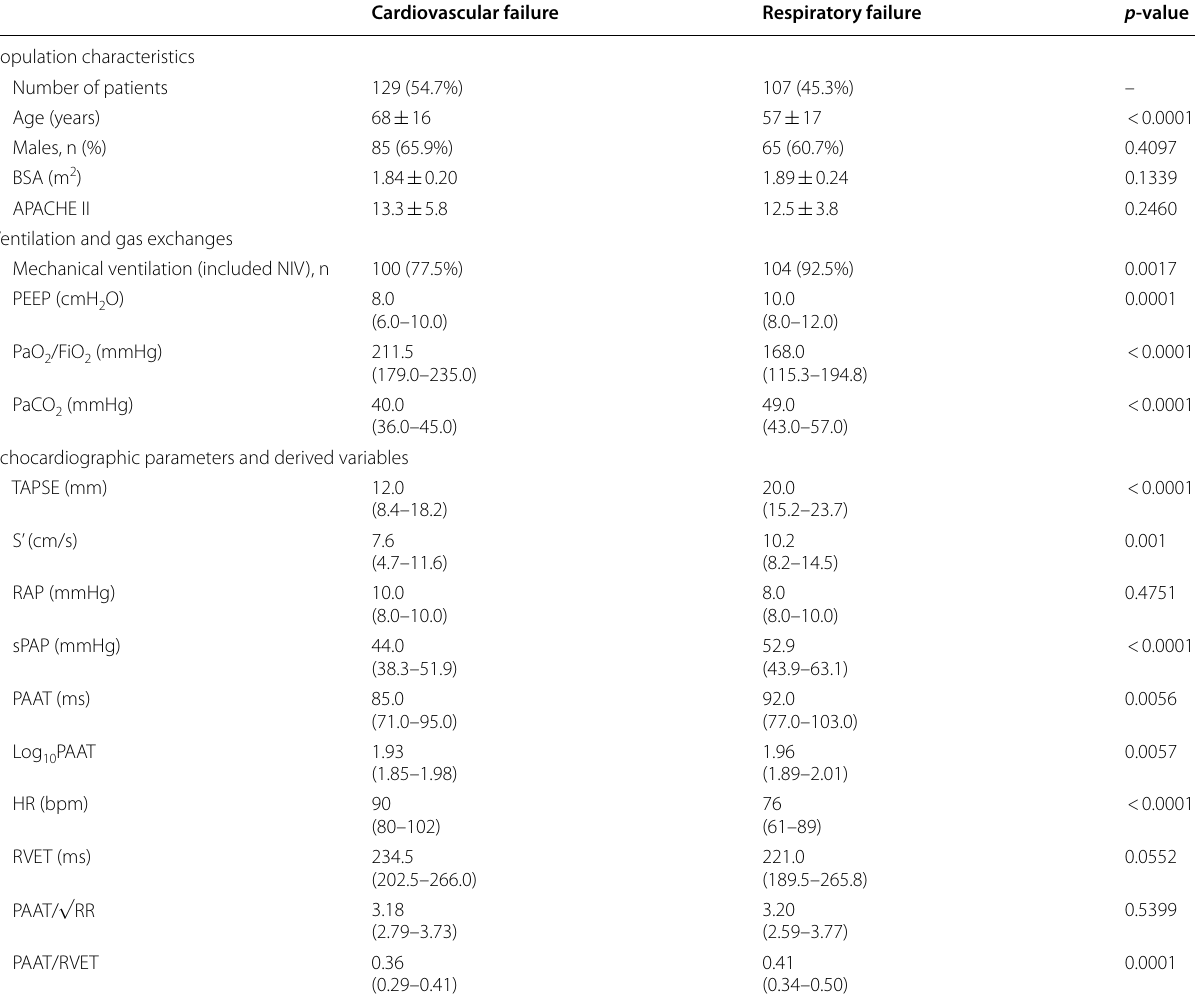
Table 2 Characteristics, respiratory variables and echocardiographic parameters of patients admitted to ICU for acute